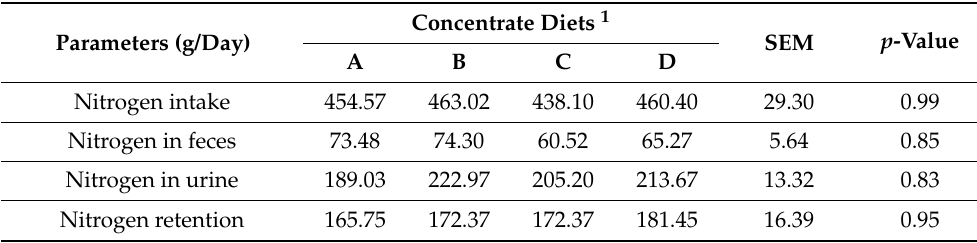
Table 4. Effect of different levels of yeast-fermented citrus pulp on nitrogen balance in cannulated buffalo